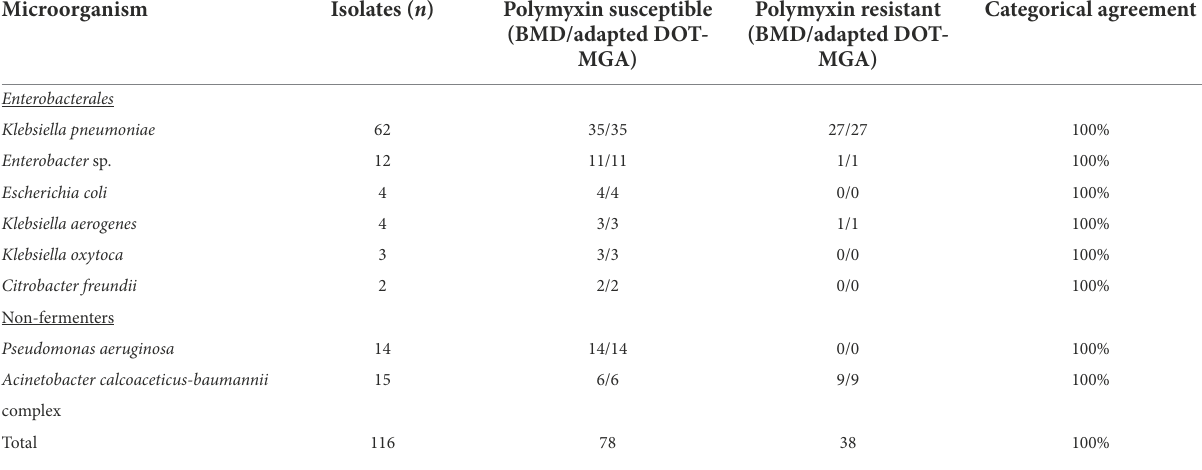
TABLE 2 Comparison of polymyxin B susceptibility of adapted DOT-MGA directly from positive blood cultures with BMD.